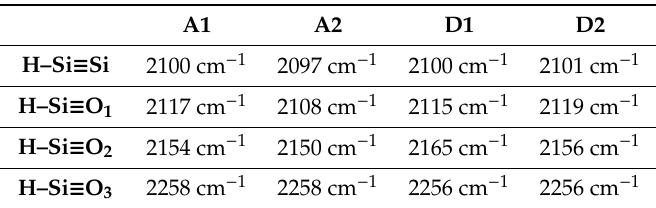
Table 7. Si–H stretching vibration